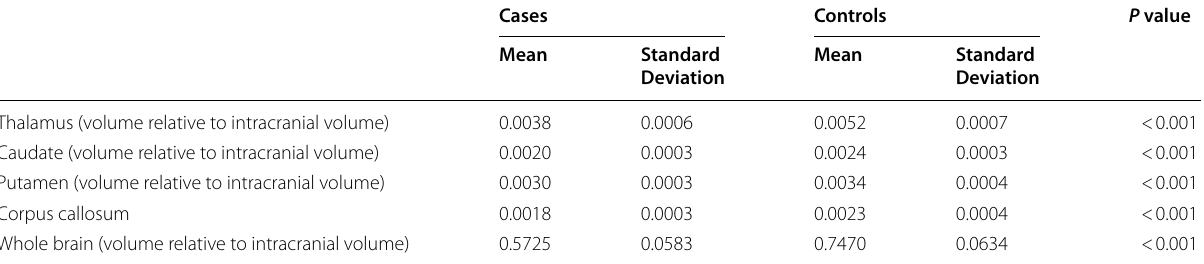
Table 4 Comparison of mean volume of thalamus, whole brain, caudate and putamen and corpus callosum in between cases and control